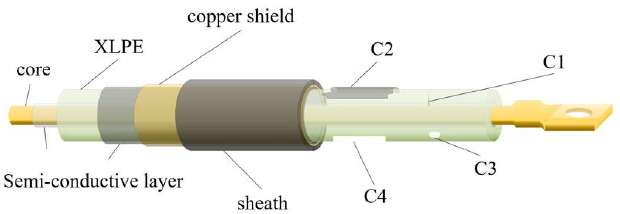
Figure 2. Typical insulation defects for XLPE cables.